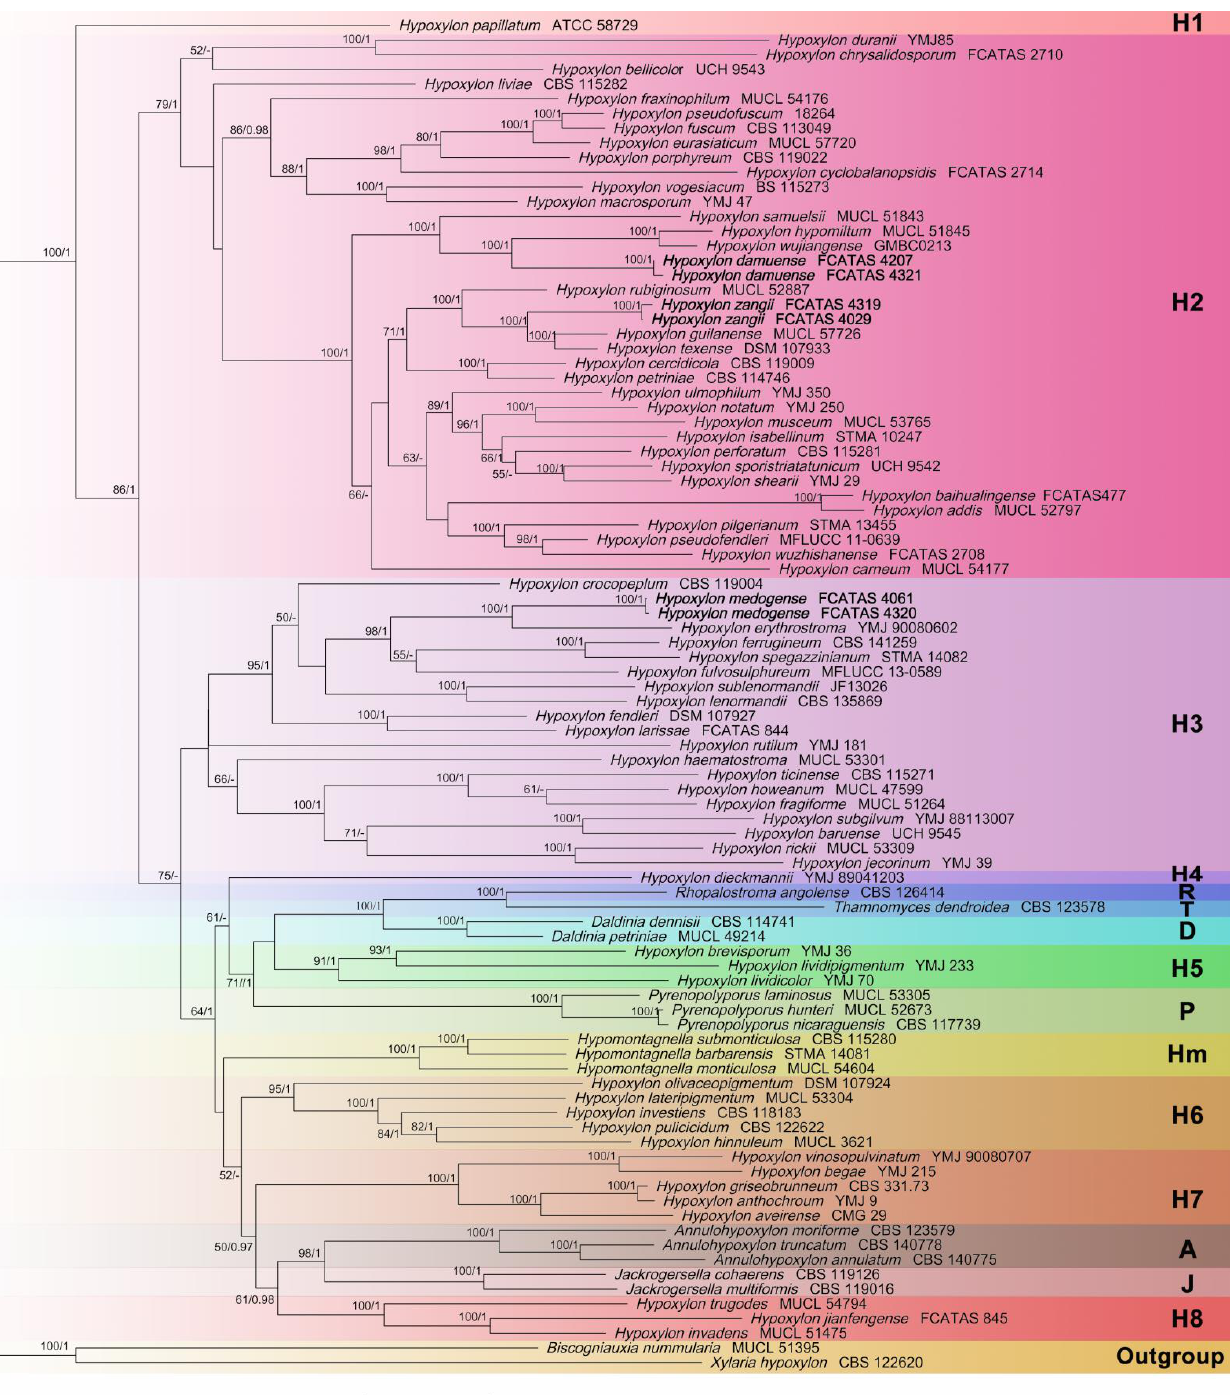
Figure 1. Phylogram of the best ML trees of the Hypoxylon species from an analysis based on multi- gene alignment of ITS-LSU-RPB2- β -tubulin. ML bootstrap support (BS) ≥ 50% and Bayesian posterior probabilities (PP) ≥ 0.95 are labelled above or below the respective branches (BS/PP). Species in bold were sequenced in this study.